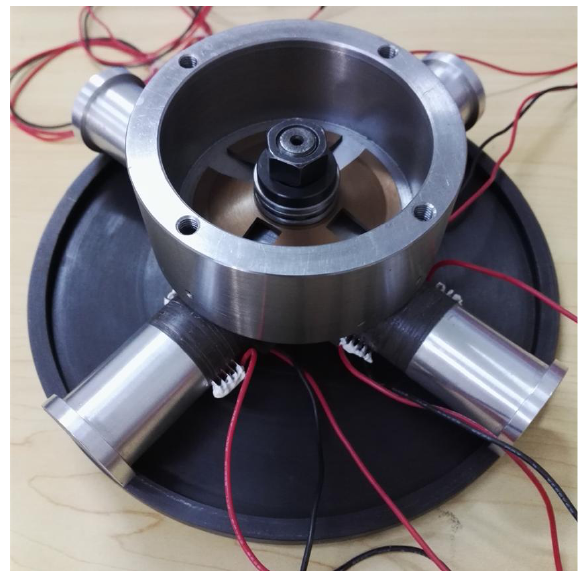
Figure 7. Photo of the prototype.